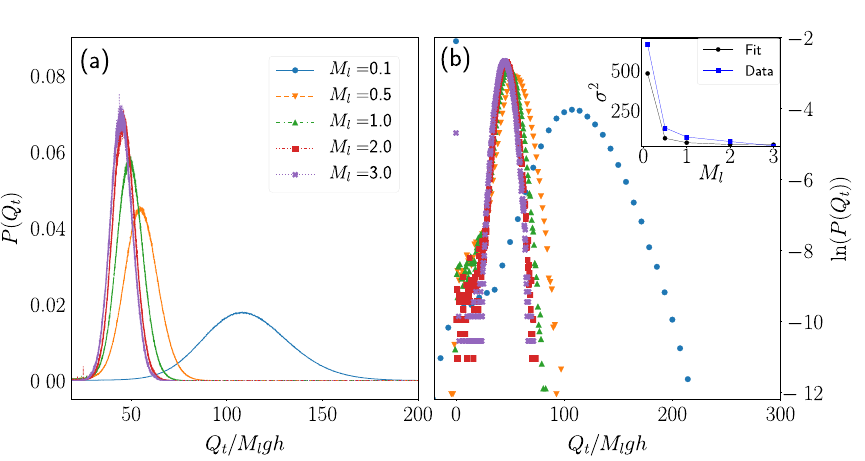
Figure 9. Heat distribution at fixed porosity. ( a ) Pdf of the heat exchanged between the particle and the thermal walls during a time window t = 40 ¯ t c for systems with p = 0.2 and several values of M l . ( b ) Logarithm of the data shown in ( a ). Inset: Variance of the distribution computed from a Gaussian fit to the data around its maximum (squares) and from the numerical computation using all the heat data